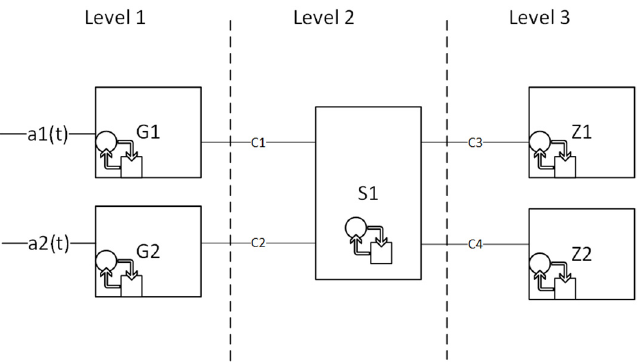
Figure 1. Block diagram of the control system under study.